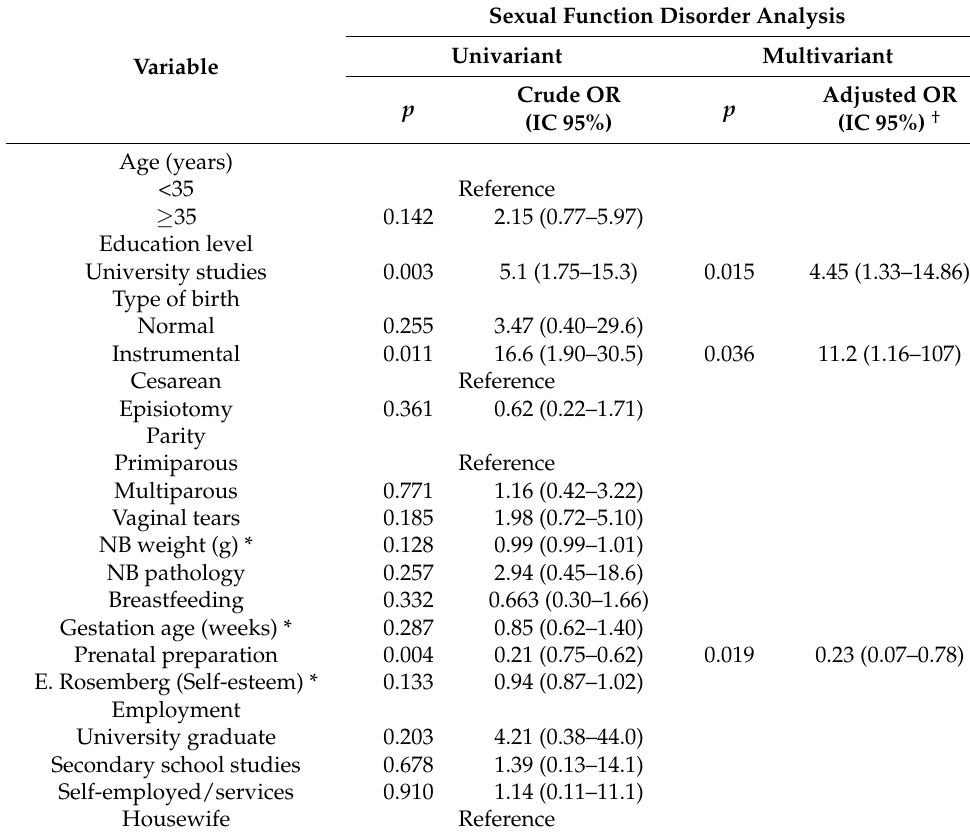
Table 4. Factors associated with the risk of female sexual